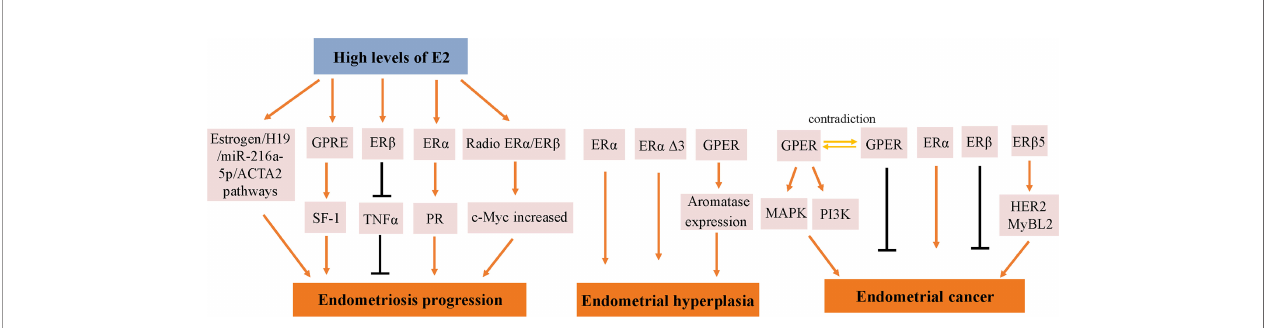
FIGURE 2 | Molecular pathways regulated by ER in endometrial diseases. E2, estradiol; ER, estrogen receptor; GPER, G-protein-coupled estrogen receptor; SF-1, steroidogenic factor 1; TNF a , tumor necrosis factor a ; PR, progesterone receptor; MAPK, mitogen-activated protein kinases;